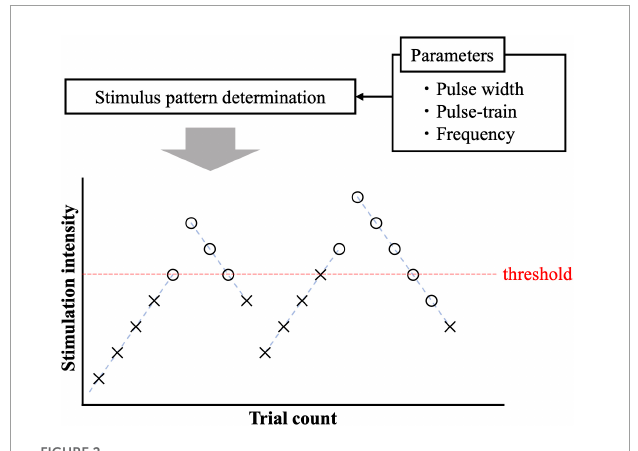
FIGURE2 Pain threshold detection using ascending and descending trials. The circle and cross signs represent cases with and without response.